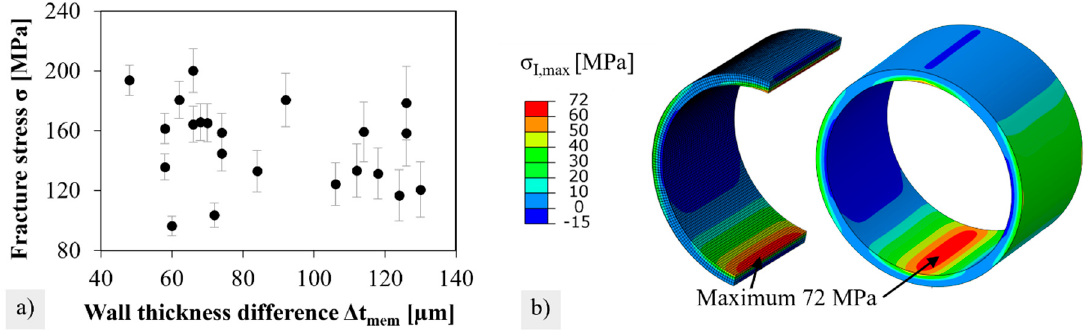
Figure 7. ( a ) Data cloud of fracture stress versus wall thickness difference for reference series 1. ( b ) Stress distribution in a brittle ring specimen.